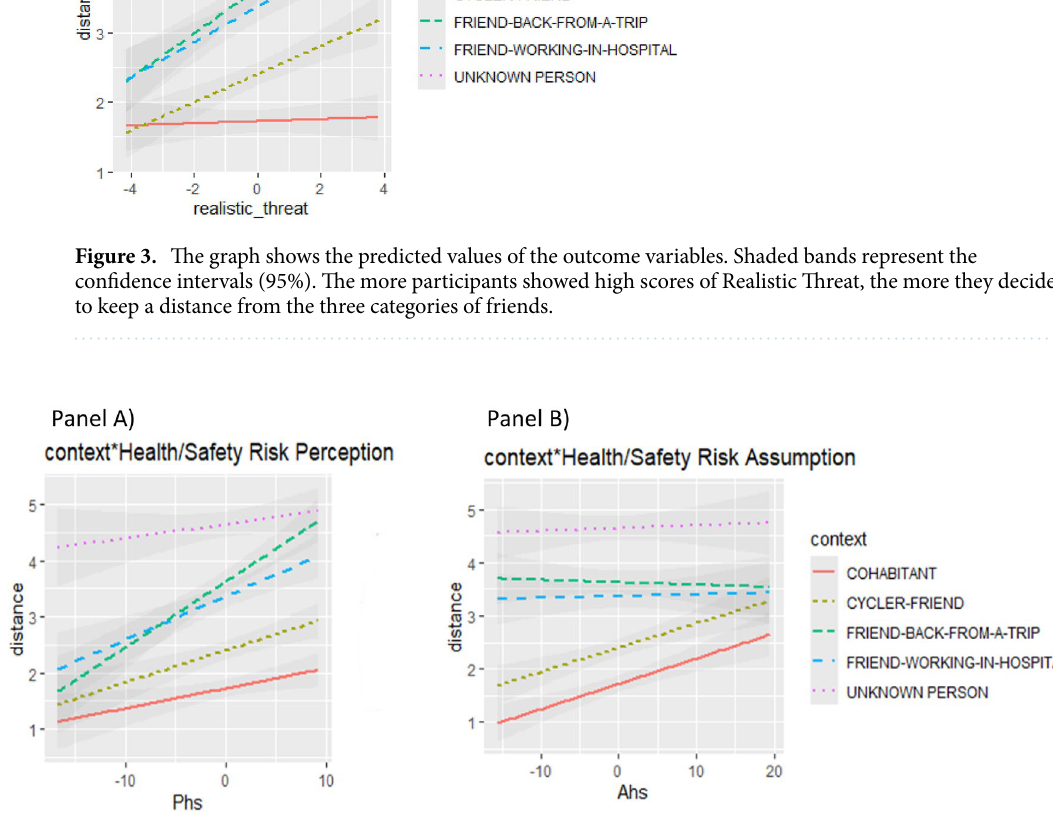
Figure 4. ( A ) The graph shows the predicted values of the outcome. Shaded bands represent the confidence intervals (95%). The higher participants’ scores of Health/Safety Risk Perception are, the more they decided to keep a distance from the three categories of friends. ( B ) The graph shows the predicted values of the outcome variables. Shaded bands represent the confidence intervals (95%). Results indicate that the higher participants’ score in the Health/Safety Risk Assumption are, the more they keep distance from the Cohabitant and Cycler slopes of the FRIEND-BACK-FROM-A-TRIP and the UNKNOWN PERSON (estimate = 0.09444, SE = 0.0186, t(1727) = 5.079 p<0.0001) were significant. The pairwise difference between the simple slopes of the FRIEND- WORKING-IN-HOSPITAL and the UNKNOWN PERSON as a function of Health/Safety Risk Perception was significant (estimate = 0.05527, SE = 0.0186, t(1727) = 2.972 p=0.0249) Fig. 4). The higher the level of Health/ Safety Risk Perception was, the more participants decided to keep their distance from the three categories of friends. This pattern of results overlaps with the one found for the Realistic Threat subscale of the Integrated COVID-19 Threat Scale. Experiencing the risk that our health is vulnerable to the infection impacts on the preferred interpersonal distance which participants decide to keep from friends and not from the cohabitant or the unknown person. Simple slope analysis showed that the slopes of the CYCLER-FRIEND [LCI 0.0179–UCI 0.1181] and the COHABITANT [LCI 0.0162–UCI 0.1164] were significantly different from zero as a function of the Health/Safety Risk Assumption. The pairwise difference between the simple slopes of the FRIEND-BACK-FROM-A-TRIP and the CYCLER-FRIEND as a function of Health/Safety Risk Assumption (estimate = − 0.0423, SE = 0.0135, t(1727) = − 3.131 p=0.0153), as the pairwise difference between the simple slopes of the FRIEND-BACK-FROM- A-TRIP and the COHABITANT (estimate = − 0.04065, SE = 0.0135, t(1727) = − 3.004 p=0.0227) were significant. The pairwise difference between the simple slopes of the CYCLER-FRIEND and the FRIEND-WORKING-IN- HOSPITAL as a function of Health/Safety Risk Assumption (estimate = 0.04095, SE = 0.0135, t(1727) = 3.026 p=0.0212) and the pairwise difference between the simple slopes of the CYCLER-FRIEND and the UNKNOWN PERSON (estimate = 0.04856, SE = 0.0135, t(1727) = 3.584 p=0.0032) were significant. Finally, both the pair- wise difference between the simple slopes of the FRIEND-WORKING-IN-HOSPITAL and the COHABITANT